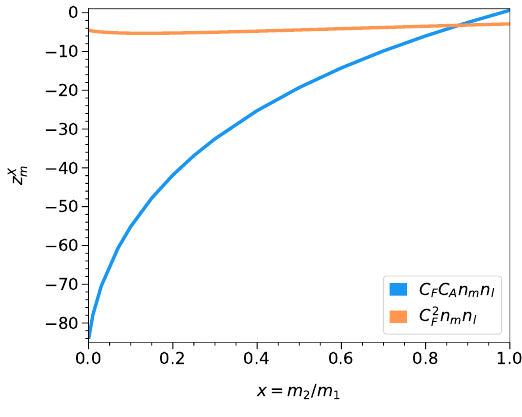
Figure 5 . Renormalized results for the coefficients z FFML